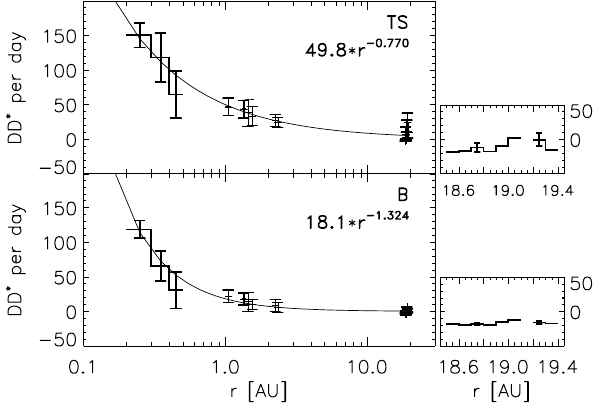
Fig. 3. Distribution of DD per day over r with a bin size of 0.1 AU and the standard deviations as error bars on logarithmic scale; TS criterion at the top and B at the bottom; darker lines represent intervals in the ecliptic which are used for the given fit and lighter ones are out of the ecliptic; right Voyager 2 in detail on linear scale.